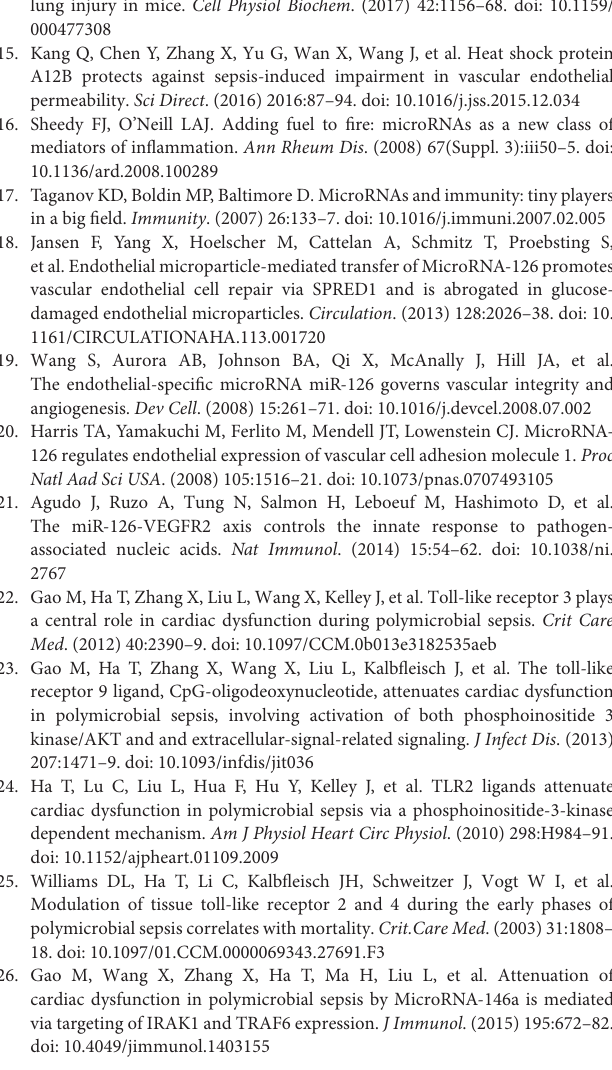
FIGURE S1 | The targeting strategy for the development of Flox/Flox